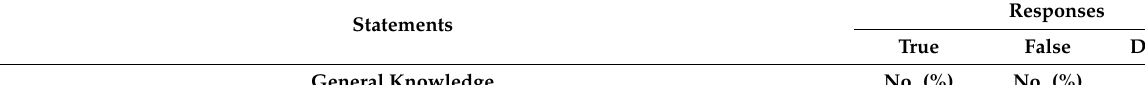
Table 2. Physicians’ responses to knowledge statements on